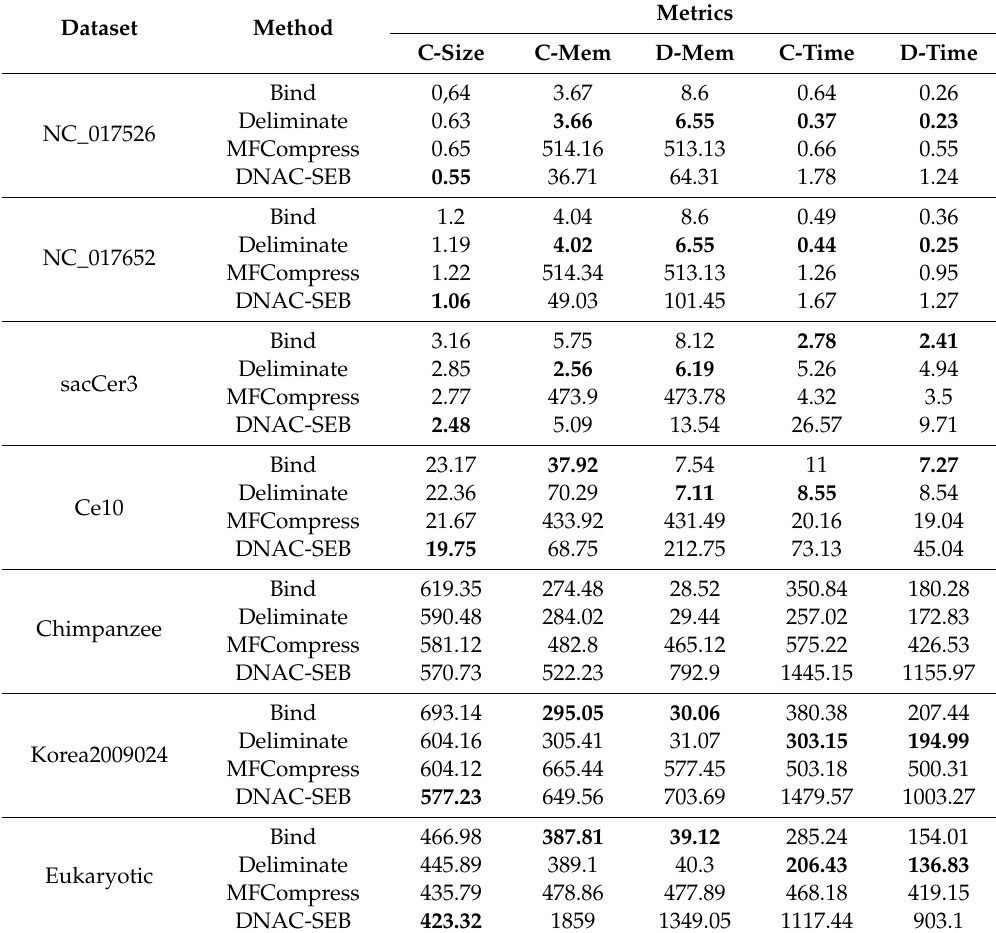
Table 7. Comparison of compressed data size, processing time and memory utilization using FASTA